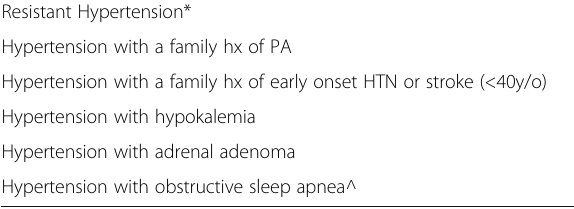
Table 1 Indications for screening for PA Resistant Hypertension* Hypertension with a family hx of PA